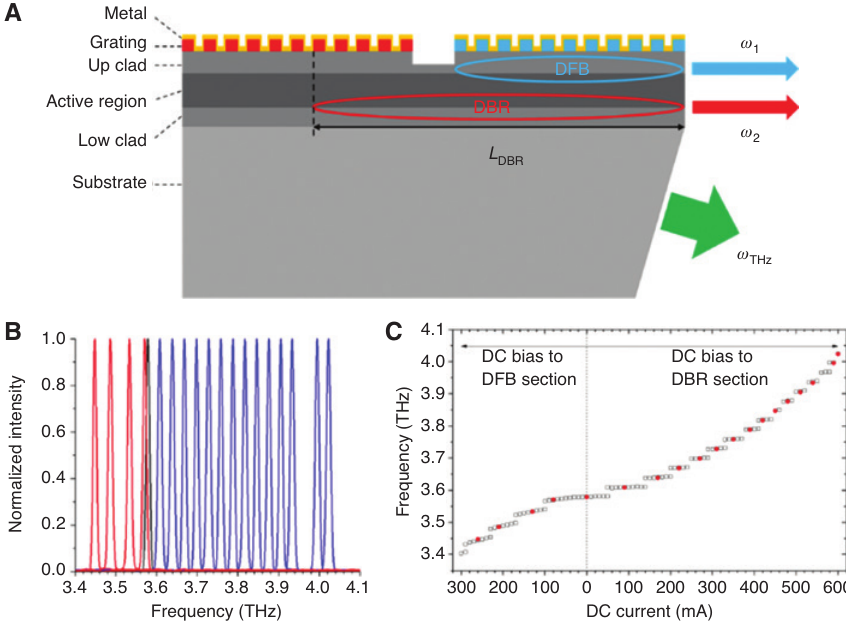
Figure 19: Monolithic tunable THz DFG-QCL. (A) Schematic of the monolithic tunable THz DFG-QCL, illustrating the front DFB section for the short wavelength ( ω ) mode selection and the 1 back DBR section for the long wavelength ( ω ) mode selection. L indicates the effective cavity length for the DBR mode. (B) THz spectra 2 DBR measured at various DC biases applied to the DFB section (the first four peaks from the left show in red) and to the DBR section (14 peaks on the right side shown in blue) in reference to the THz emission at zero DC current (the fifth peak from the left shown in black). (C) Details of THz emission tuning as a function of DC current applied to either DFB or DBR section. Open squares are THz emission frequencies calculated from the frequencies of mid-IR pumps. Filled red circles are experimentally measured positions of THz emission frequencies as shown in (B) [33,